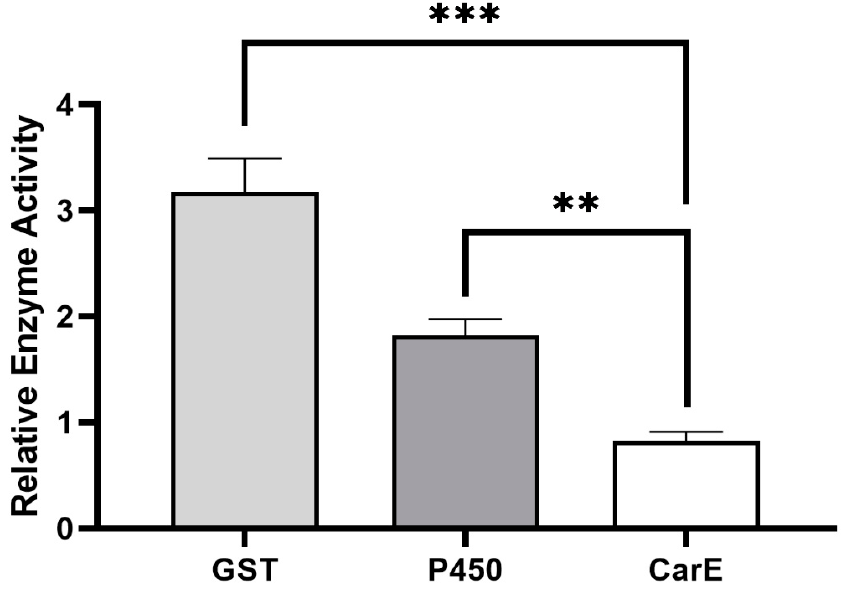
Figure 1. Differences of detoxification enzyme activities between field strains and susceptible strains of Plutella xylostella . (Bars indicate means ± standard errors of replicates. Asterisks indicate statistically significant variances (one-way ANOVA and Tukey’s multiple comparison test were used; ***, p ≤ 0.001; **, p ≤ 0.01.).